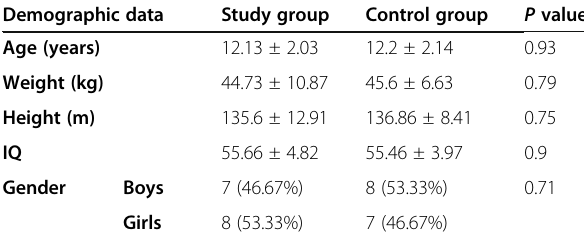
Table 1 Demographic data of the